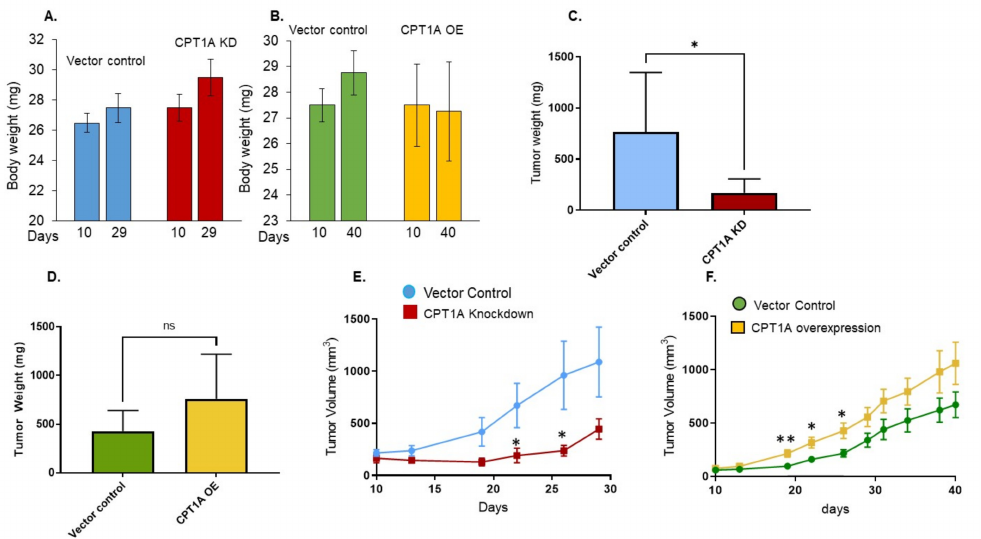
Figure 3. The effects of CPT1A expression on in vivo growth of 22Rv1 cells in immunocompromised athymic nude mice. ( A ) Mice were injected with 22Rv1 cells with vector control (V, blue) or stable knockdown (KD, red) and body weight (g) was documented at 10 and 29 days after cell injection. ( B ) Mice were injected with 22Rv1 cells with vector control (V, green) or stable overexpression (OE, yellow) and body weight (g) was documented at 10 and 40 days after injection. ( C , D ) Tumor weight (mg) was assessed at the end of the experiment: day 29 (CPT1A knockdown) (vector control n = 6; CPT1A KD n = 7) and day 40 (CPT1A overexpression) (vector control n = 8; CPT1 OE n = 8) (* p < 0.05). ( E ) On each mentioned day, tumor volume (mm3) was assessed for visible tumors from 22Rv1 CPT1A knockdown cells (red) compared to vector control (blue) and presented as mean ± SEM (* p < 0.05). ( F ) On each mentioned day, tumor volume (mm3) was assessed in tumors from 22Rv1 CPT1A overexpressing cells (yellow) compared to vector control (green) and presented as mean ± SEM ( n = 8 each group) (* p < 0.05; ** p < 0.01). ns = not